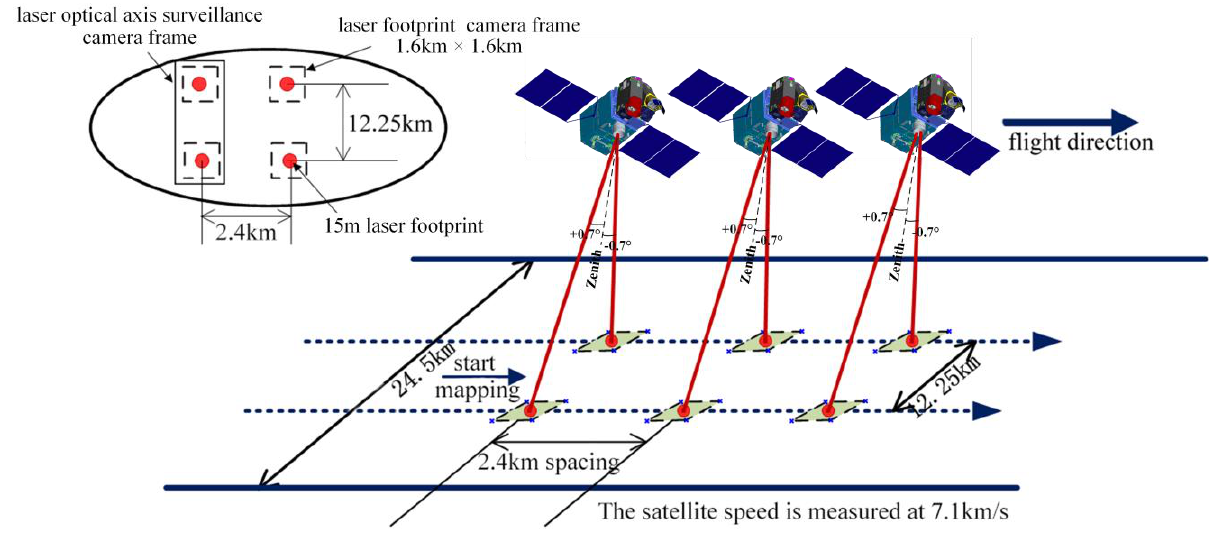
Figure 1. Schematic diagram of the GF-7 spaceborne laser altimeter system